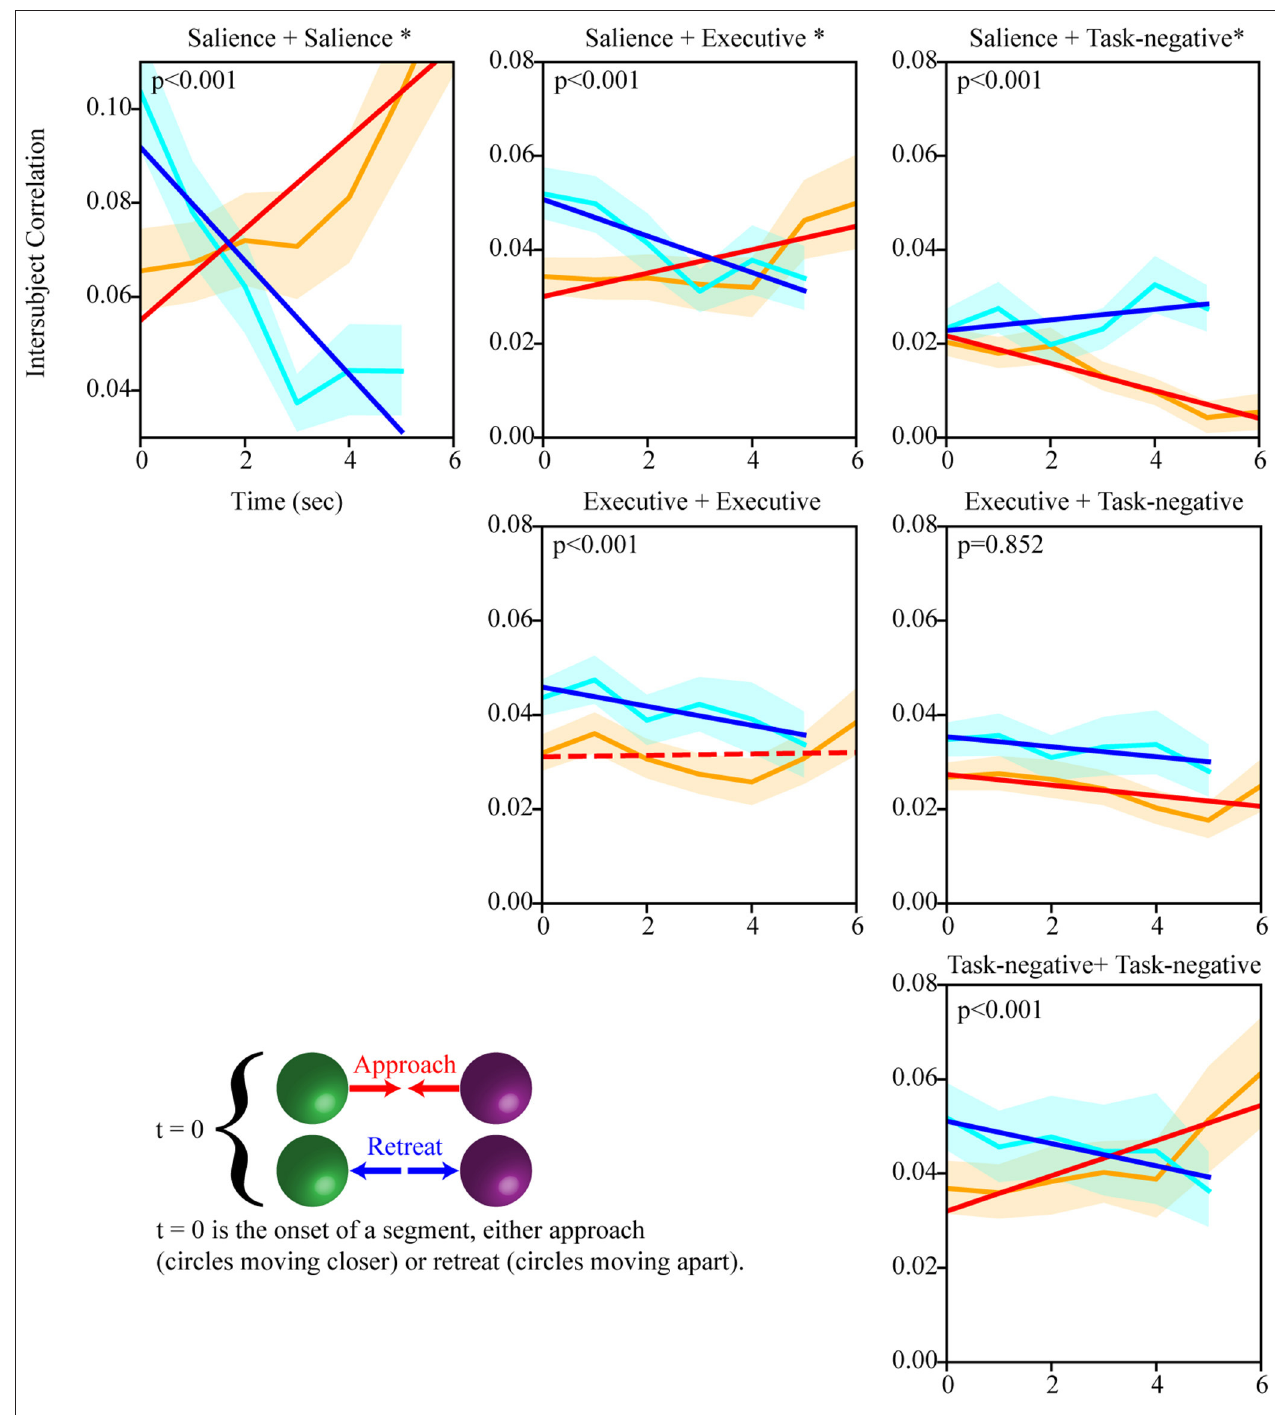
FIGURE 5 | Temporal evolution of intersubject network weight during approach and retreat segments (positive weights). Within- and between-network weights during approach and retreat for the salience, executive, and task-negative networks. For example, as the circles approached each other, the weights within the salience network increased; when the circles retreated, within-network weights decreased. Slightly longer approach periods were available to compute dynamics for this condition. The orange line shows approach weights (90% confidence band); the cyan line shows retreat weights (90% confidence band). The red/blue line show the least-squares linear fit to weight values during approach/retreat; solid lines indicate fits such that p < 0.05. Time is in seconds; the y-axis shows within/between weight. The asterisk indicates that the slope difference was such that p < 0.05.